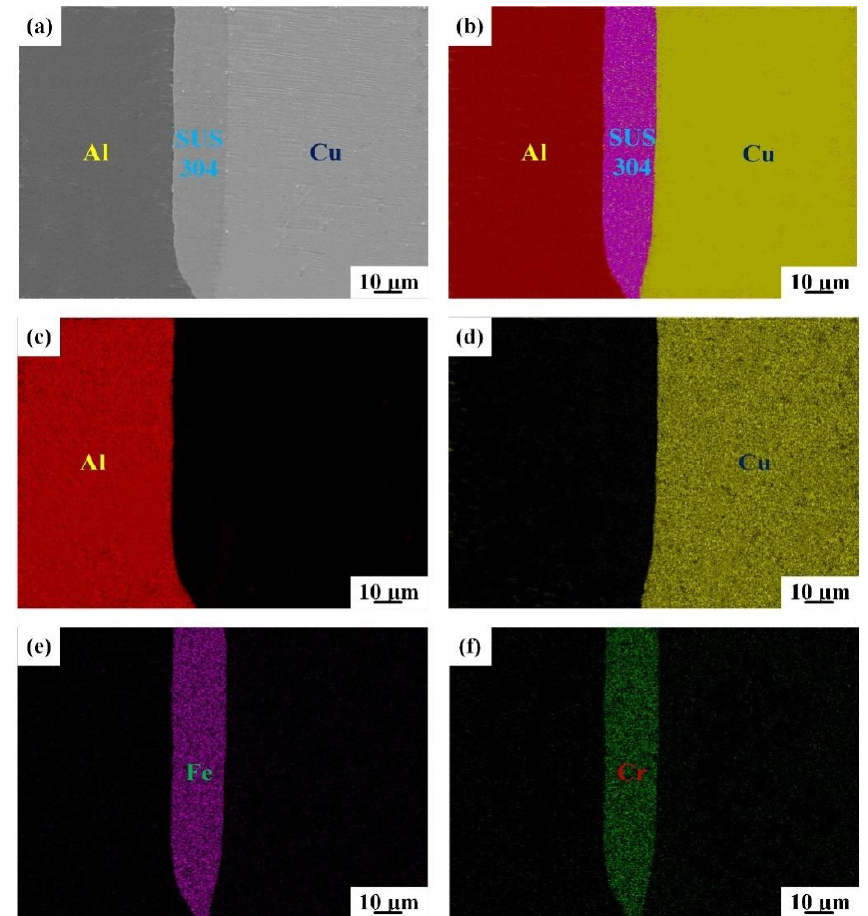
Figure 2. SEM images of the bonding interface for IFR-450 ( a ) and the corresponding EDS mapping: ( b ) EDS layered image, ( c ) Al element, ( d ) Cu element, ( e ) Fe element, ( f ) Cr